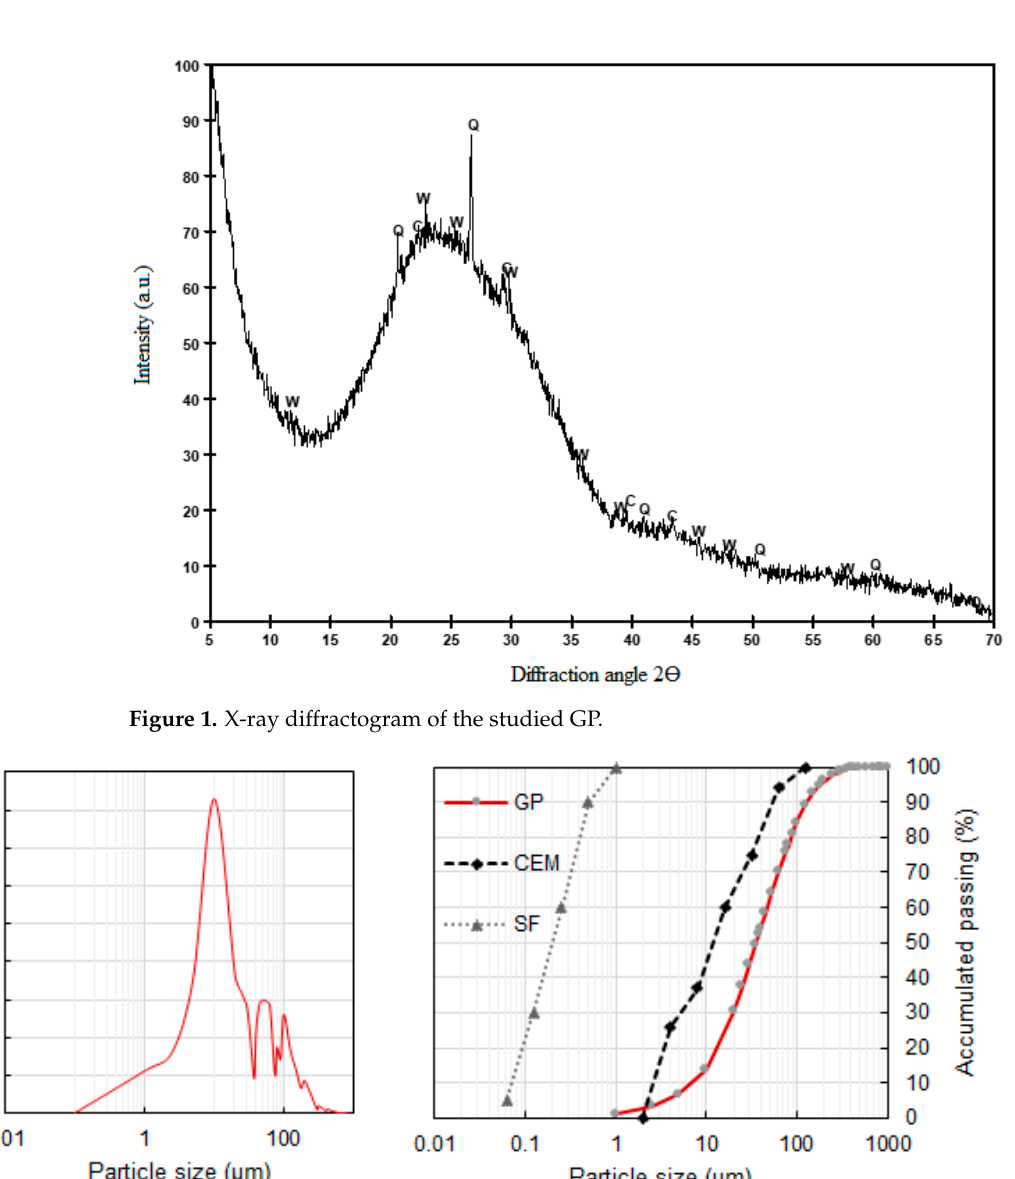
Figure 2. Particle size distribution of GP ( left ) and a comparison with CEM and SF of this study ( right ).